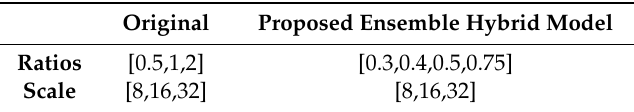
Table 4. Anchors Configuration.